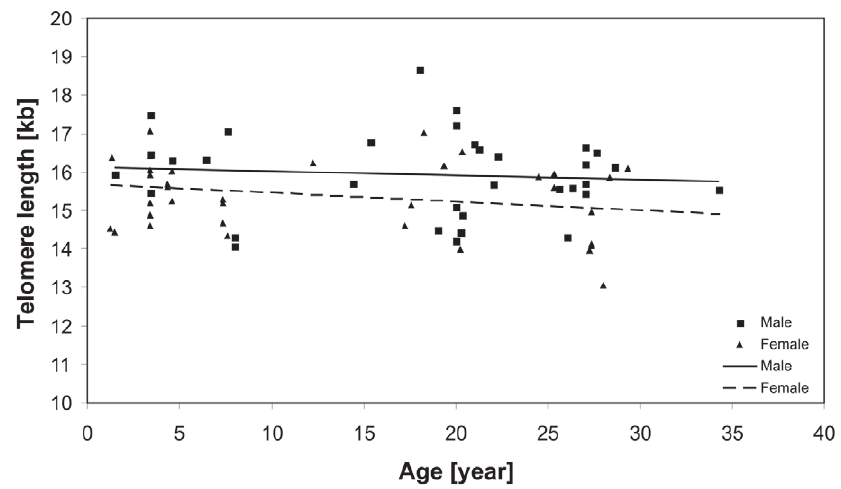
Figure 1. Telomere length of Kakapo against age. Solid line indicates regression of male TL and dotted line of female TL.